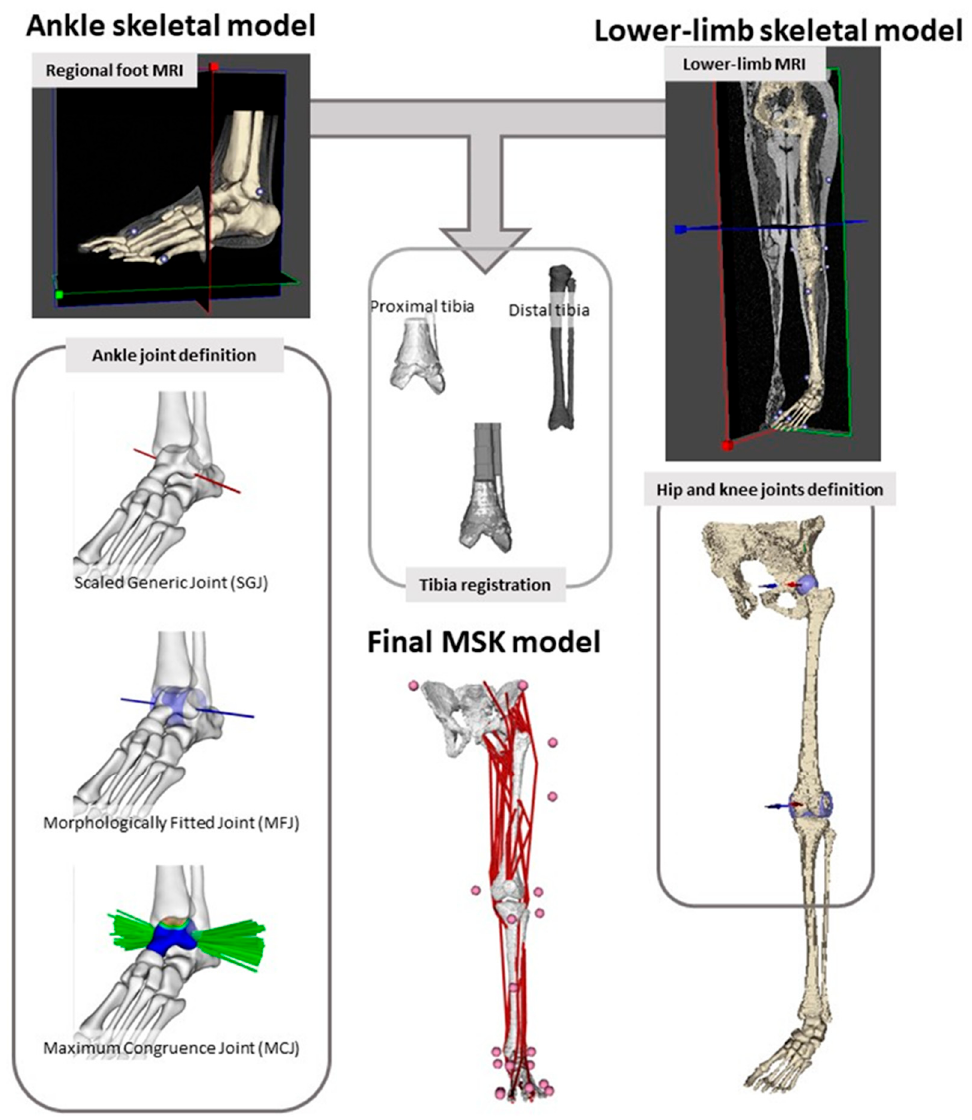
Figure 1. Definition of the personalized MSK model: anatomical information from a regional MRI taken at the foot and a whole lower-limb MRI were merged by registering the segmented tibia bones. Muscle attaching points and marker location with respect to the bones were derived from the lower-limb MRI, while MFJ and MCJ were defined based on detail representation of the ankle articulating surfaces.